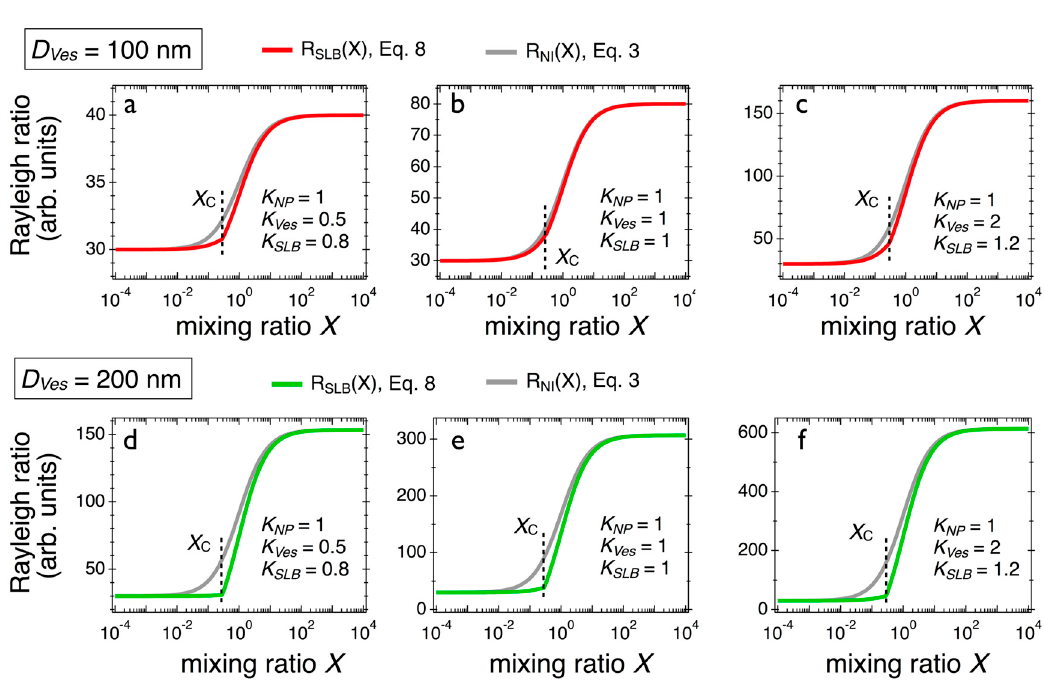
Figure 3. ( a – c ) Scattering intensity obtained for 40 nm silica nanoparticles and 100 nm lipid vesicles, forming supported lipid bilayers, using different contrasts, ( K NP , K Ves , K Agg ) = (1, 0.5, 0.8), (1, 1, 1), and (1, 2, 1.2), respectively. The curves in red refer to nano-supported lipid bilayer (nano-SLB) (Equation (8)), whereas the curves in grey arise from the non-interacting model (Equation (3)). ( d – f ) Same as above, but for 200 nm vesicles. Note that for the different conditions, the scattering intensity for the supported lipid bilayer (SLB) formation remains below that of the non-interacting species.